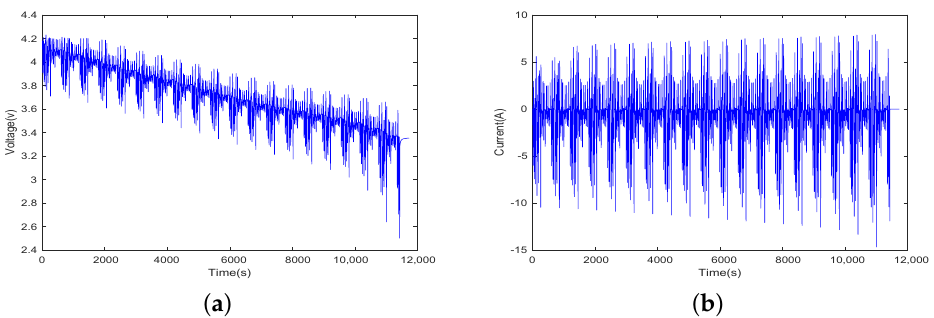
Figure 7. ( a ) Measured current and ( b ) measured voltage of the Panasonic 18650PF battery used for the training and testing phases The results of SOC estimation and SOC error for a dataset of mixed drive cycles with fixed ambient temperature at 0 and 25 ◦ C and varying ambient temperature are described in Figures 8 and 9, respectively.